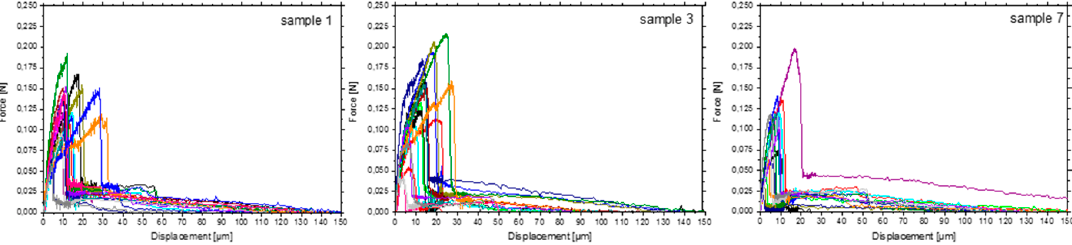
Figure 5. Force-displacement curves of sample 1 (no surface treatment), sample 3 (medium current, medium conductivity) as the most extensive, and sample 7 (low current, high conductivity) with the lowest fibre-matrix interaction, respectively.